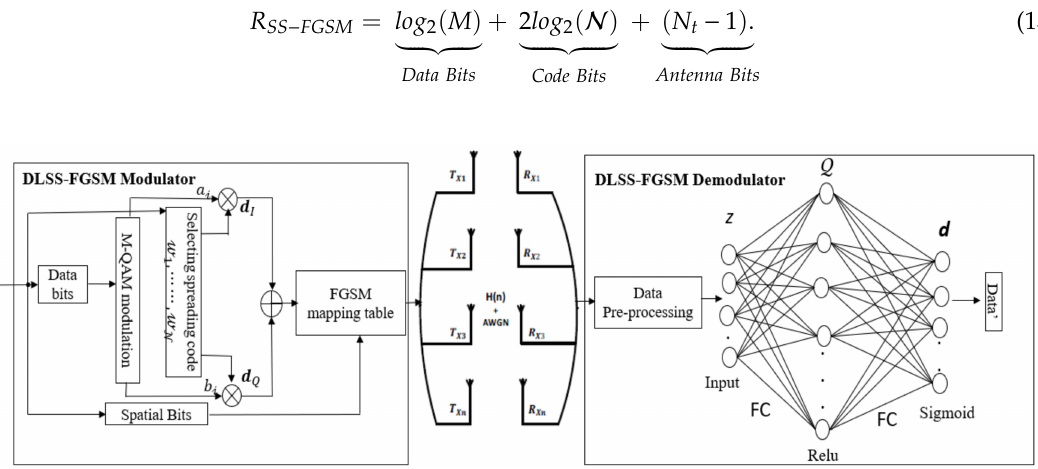
Figure 1. Proposed DLSS-FGSM transmitter and receiver